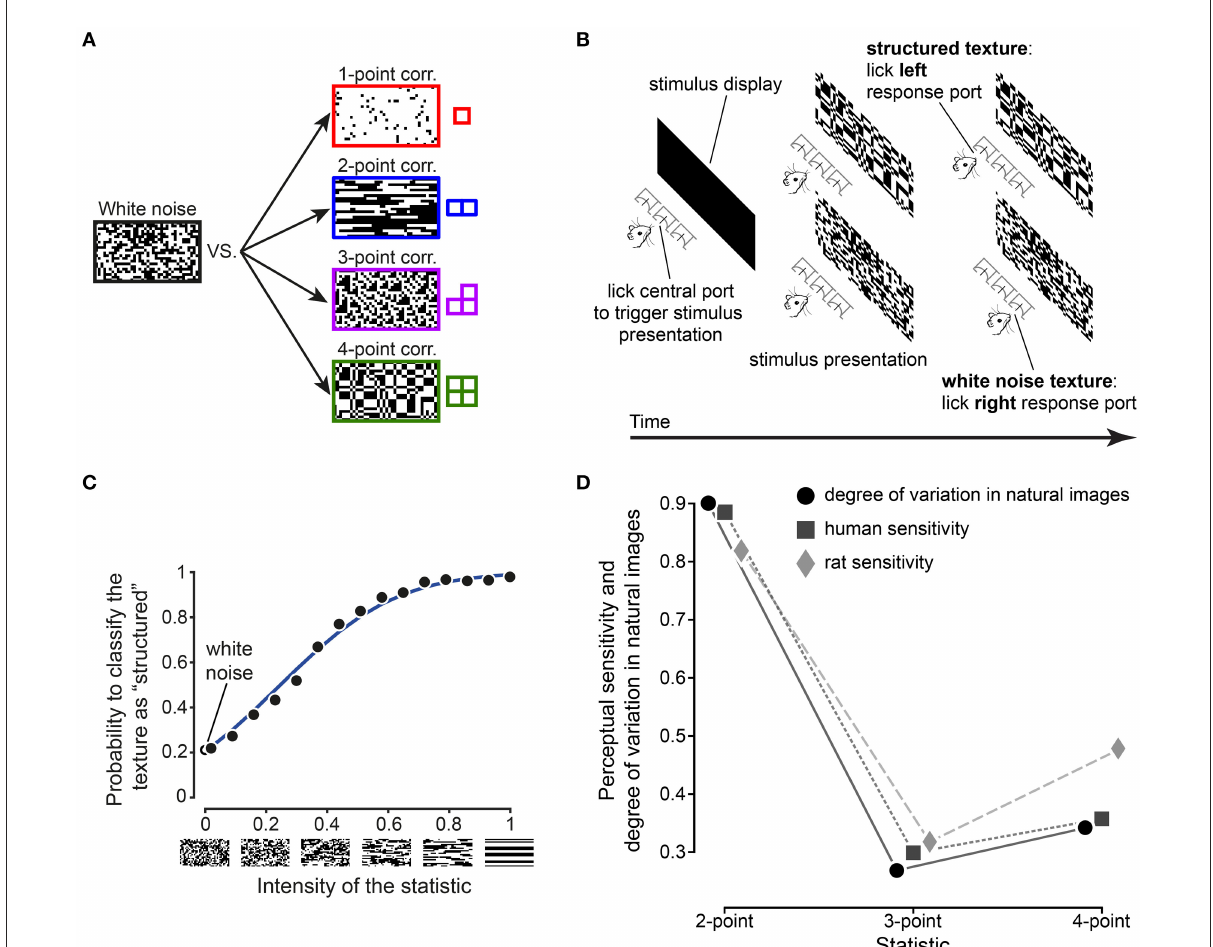
FIGURE4 Rat sensitivity to visual multipoint correlations verifies the prediction from efficient coding theory, matching that found in humans. (A) Example stimuli used in the psychophysics task. Rats performed a two-alternative forced choice task where they had to report if a given stimulus was an instance of structured noise (a correlated pattern with one-, two-, three-, or four-point structure, generated using the gliders on the right), or unstructured “white” noise. (B) Operant structure of the psychophysics task. (C) Example psychometric curve from one of the rats trained to distinguish 2-point correlated textures from white noise. Black dots: experimental data. Blue line: ideal observer model fit. (D) Comparison between rat and human sensitivity to structured textures (diamonds and squares, respectively), and degree of variability of the corresponding statistics in natural images (dots). Adapted from Caramellino et al.